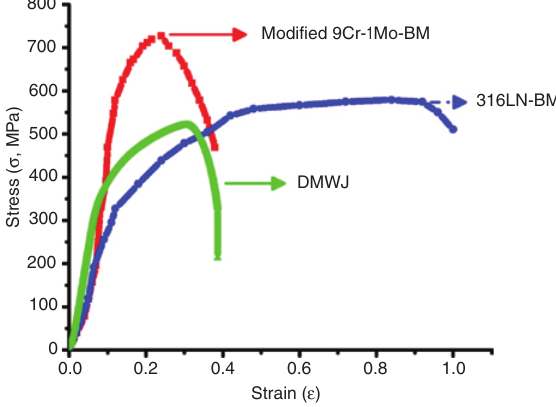
Figure 2: Scheme of extraction of tensile and impact specimens.